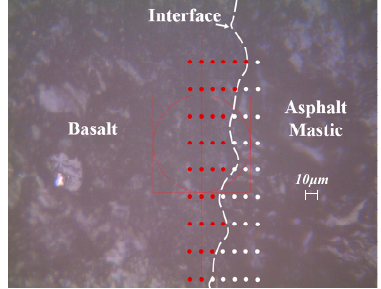
Figure 5. Distribution of indentation positions.